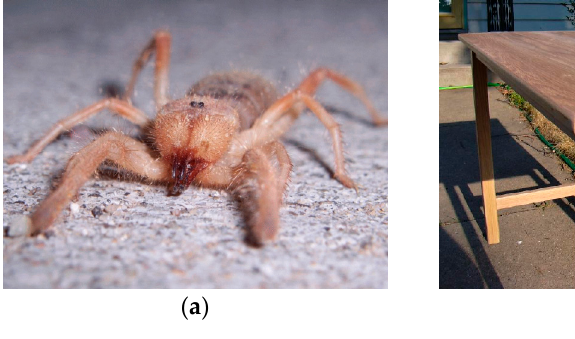
Figure 1. Geneva Affective Picture Database (GAPED) images used in the study. ( a ) negative; ( b ) neutral; ( c ) positive. Table 2. Attributes used for the sensory acceptance test of the Geneva Affective Picture Database images and six beer samples.